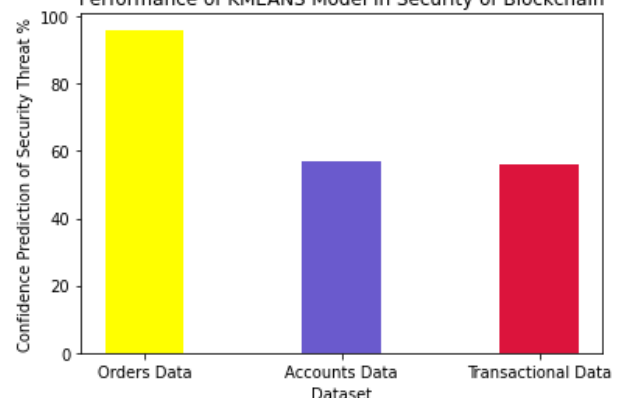
Figure 9. Performance of KMEANS model in securing the